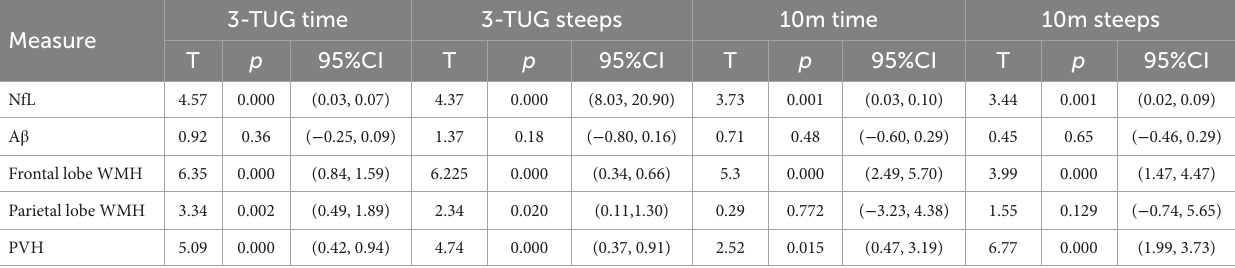
TABLE 2 Linear regression model showed the influence of each CSF pathological marker and regional WMH on gait disorder.